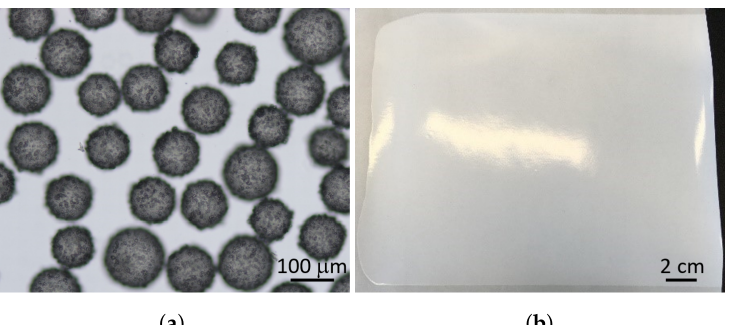
Figure 3. Components of the new membrane setup. ( a ) Spherical aminoplast microcapsules filled with eucalyptus oil. ( b ) Polymeric flat sheet ultrafiltration membrane made from polyacrylonitrile with nonwoven